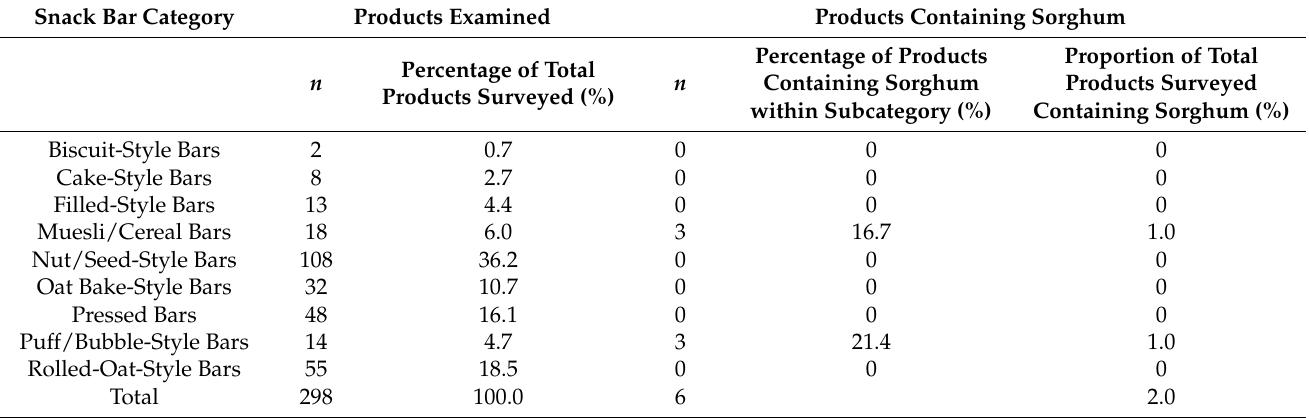
Table 2. Prevalence of sorghum ingredients in snack bars surveyed in the supermarket audit.